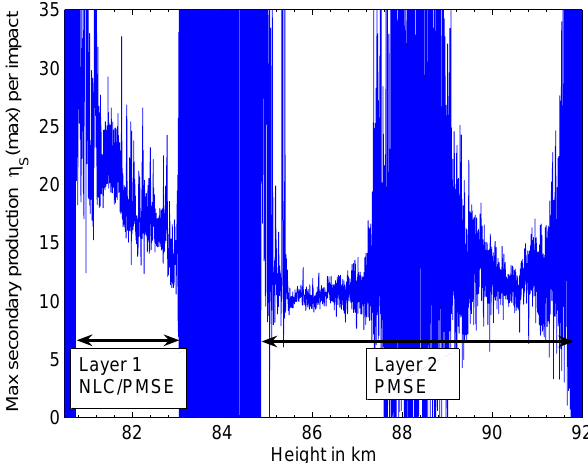
Fig. 12. The computed η S ( max ) for the two dust layers. We show here the results for the sinus-correction for the background varia- tions. The Fourier representation gives only small changes to the results in the two